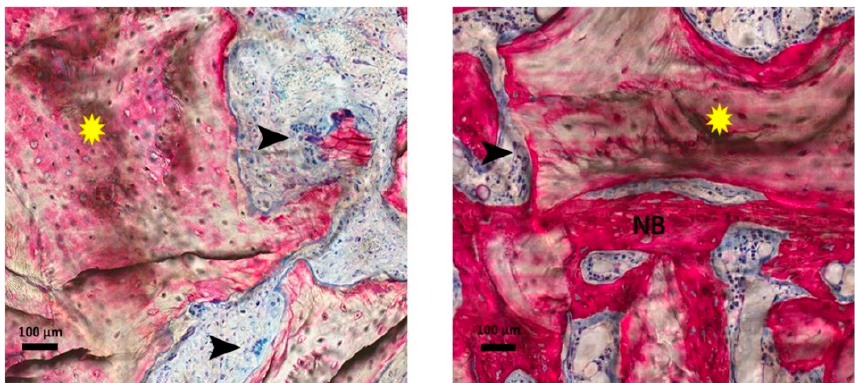
Figure 2. Representative histological sections of specimens from different study groups showing a transverse section through the femoral condyle, perpendicular to the long axis of the cylindrical bone defect. A circular region depicting the region of interest (ROI) is shown separately as an off- set image for each group.